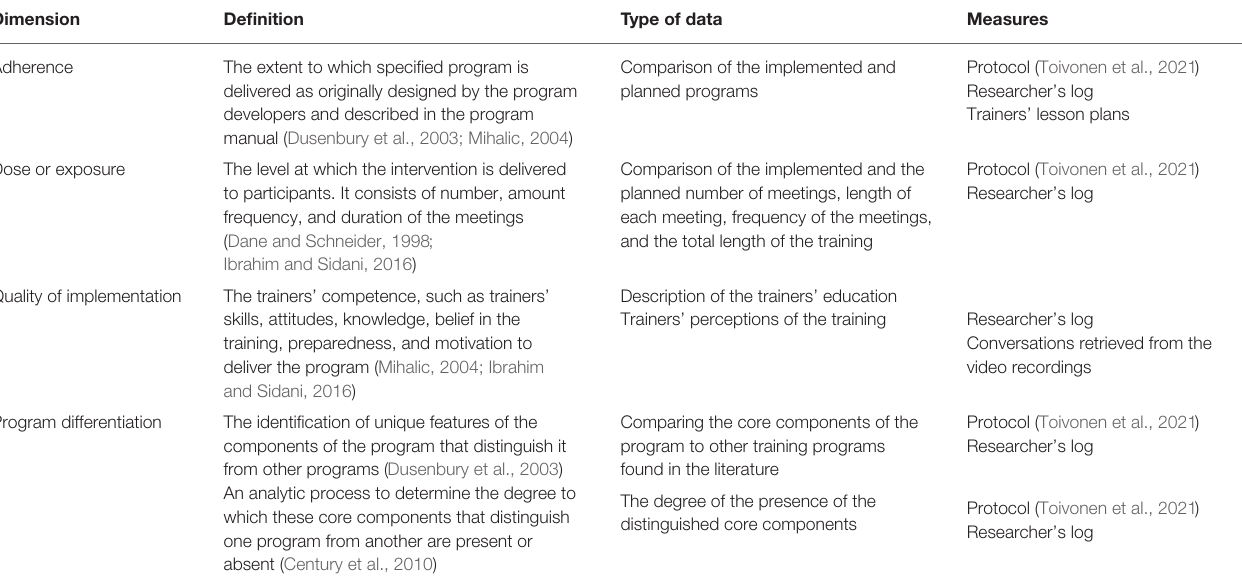
TABLE 2 | The definitions, type of data, and measures of the examined implementation fidelity dimensions.